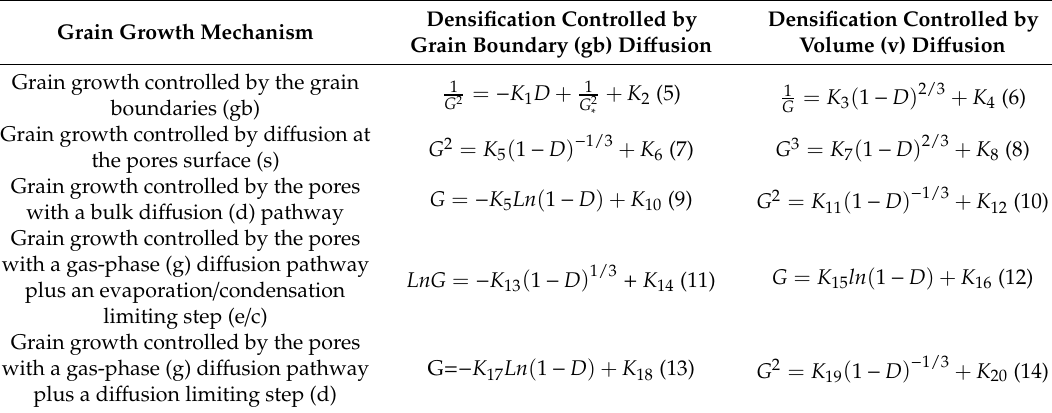
Table 1. Grain size versus relative density